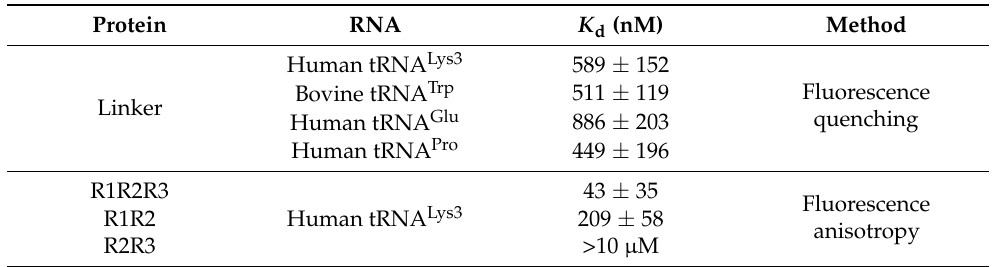
Table 1. Apparent binding dissociation constants between tRNA and EPRS linker. Binding assays were performed with 5 nM fluorescently labeled tRNAs and serially diluted proteins in 20 mM Tris-HCl pH 8, 50 mM NaCl, and 1 mM MgCl 2 . The results are the average of three independent trials with standard deviation